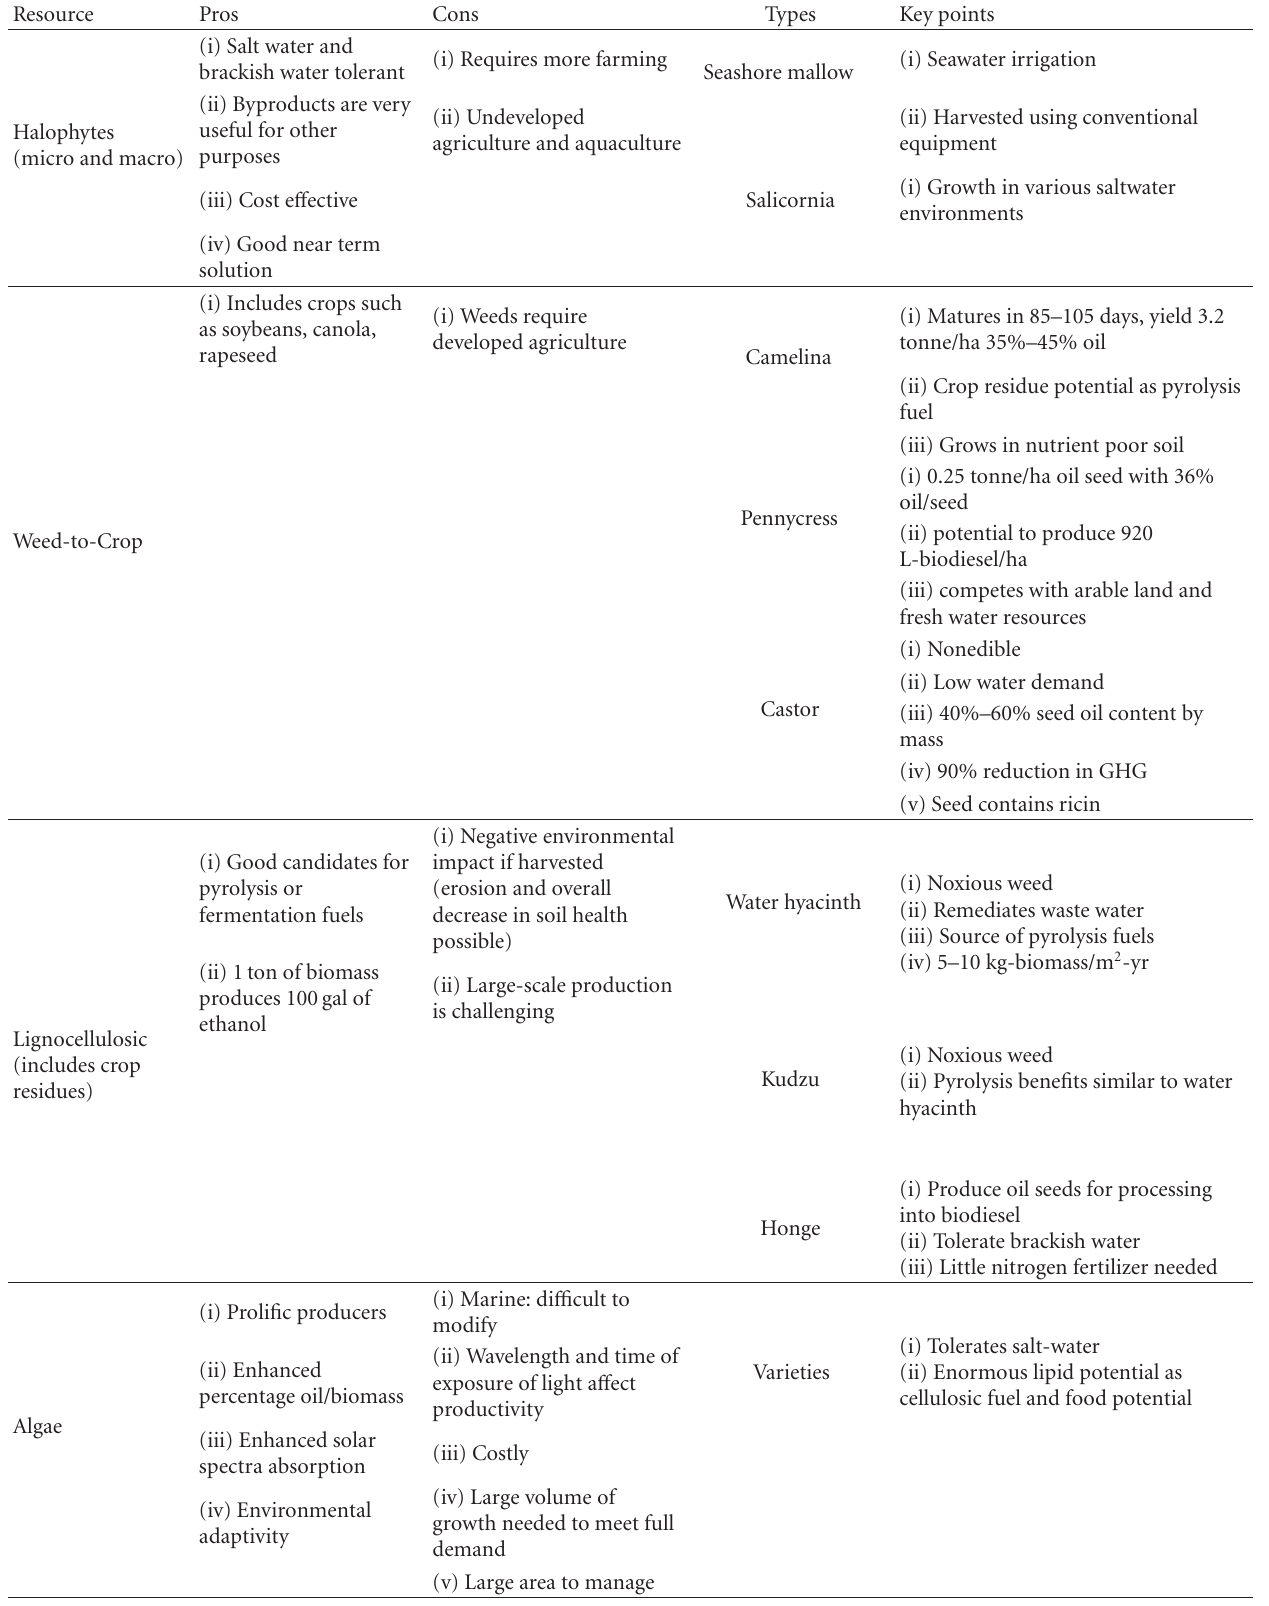
Table 1: Overview of biomass